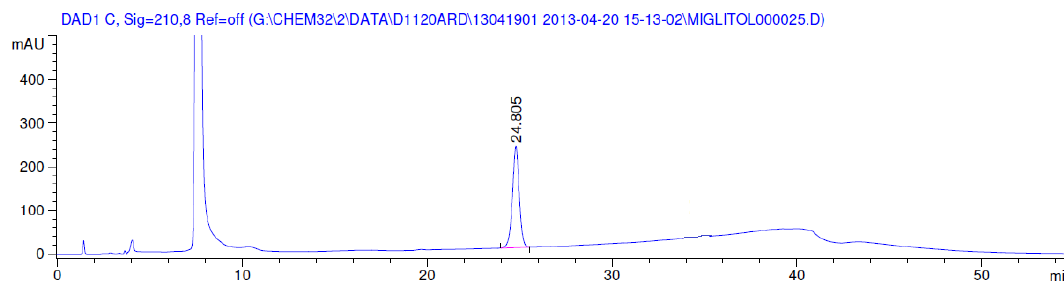
Figure 8. Chromatogram in oxidative degradation.